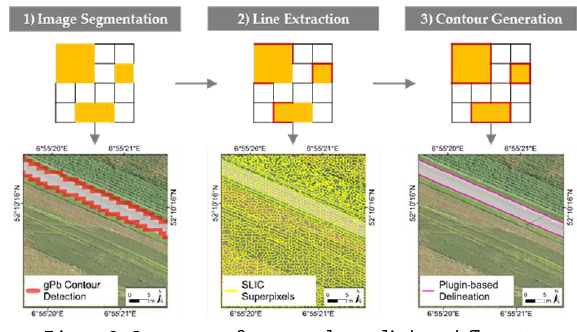
Figure 3. Sequence of commonly applied workflow steps proposed in (Crommelinck et al., 2016) to extract objects related to those manifesting cadastral boundaries from high- resolution optical sensor data